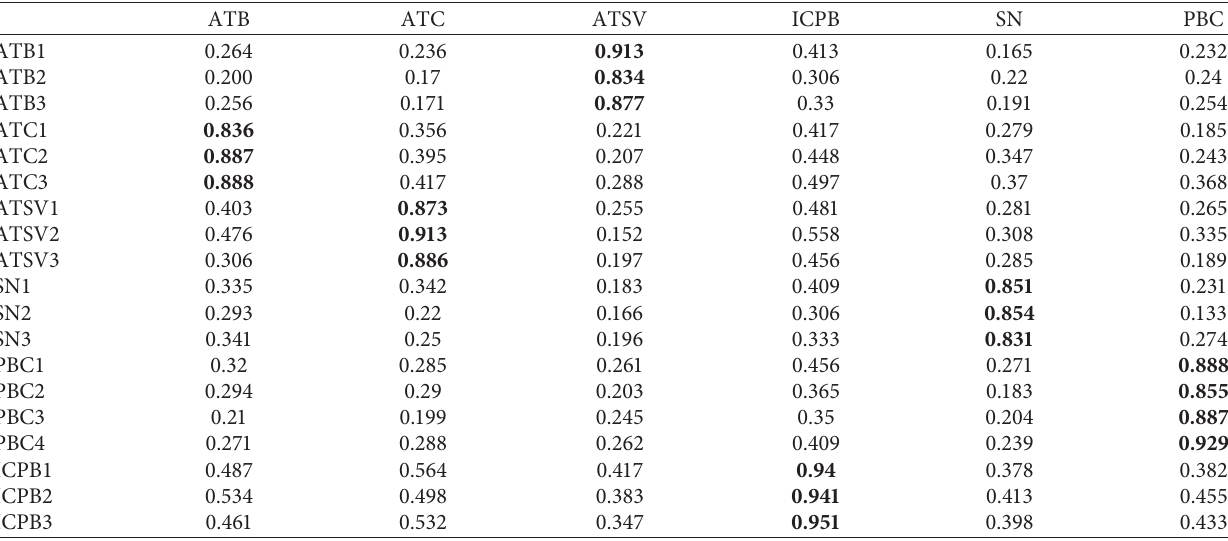
Table 4: Cross-loadings for measurement